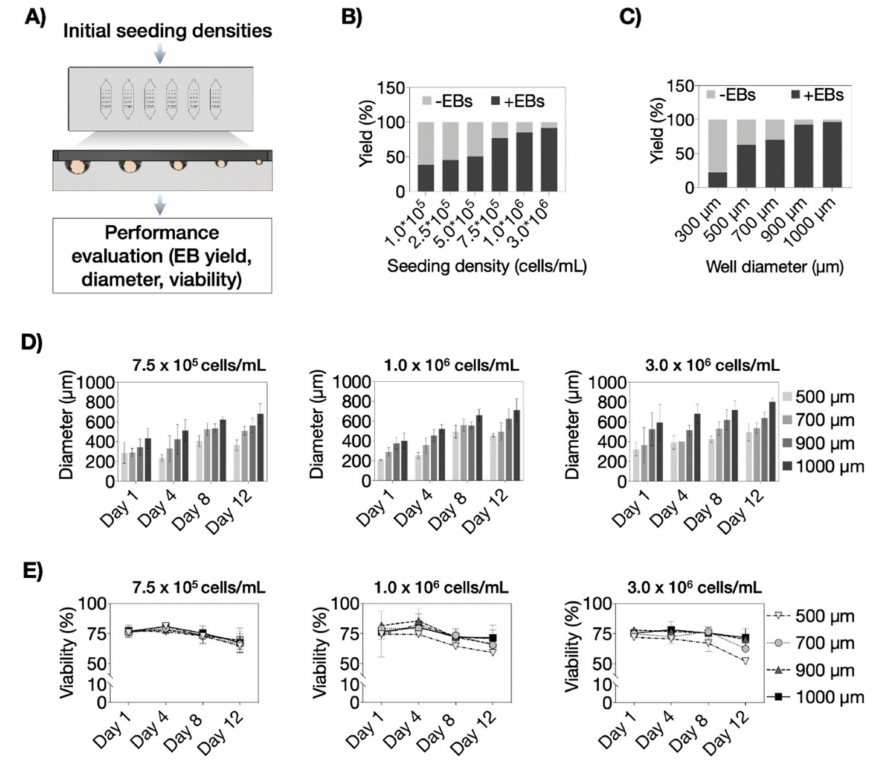
Figure 6. ( A ) Embryoid body (EB) size pre-screening concept using multi-size biochip array by evaluating EB yield, EB diameter, and EB viability. Average EB production yield at respective ( B ) initial seeding densities and ( C ) biochip well diameters during a cultivation period of 12 days in the microfluidic array. ( D ) EB size separation by different microwell diameters (500–1000 µ m) at initial seeding densities of 7.5 × 10 5 cells/mL, 1.0 × 10 6 cells/mL, and 3.0 × 10 6 cells/mL for 12 days post-seeding in the microfluidic device. Statistical significance was tested by using one-way ANOVA, n = 3 ± SD. Bars without * do not represent statistical significance. ( E ) Time-resolved monitoring of the impact of initial seeding densities and microwell sizes on EB viability, n = 3 ±